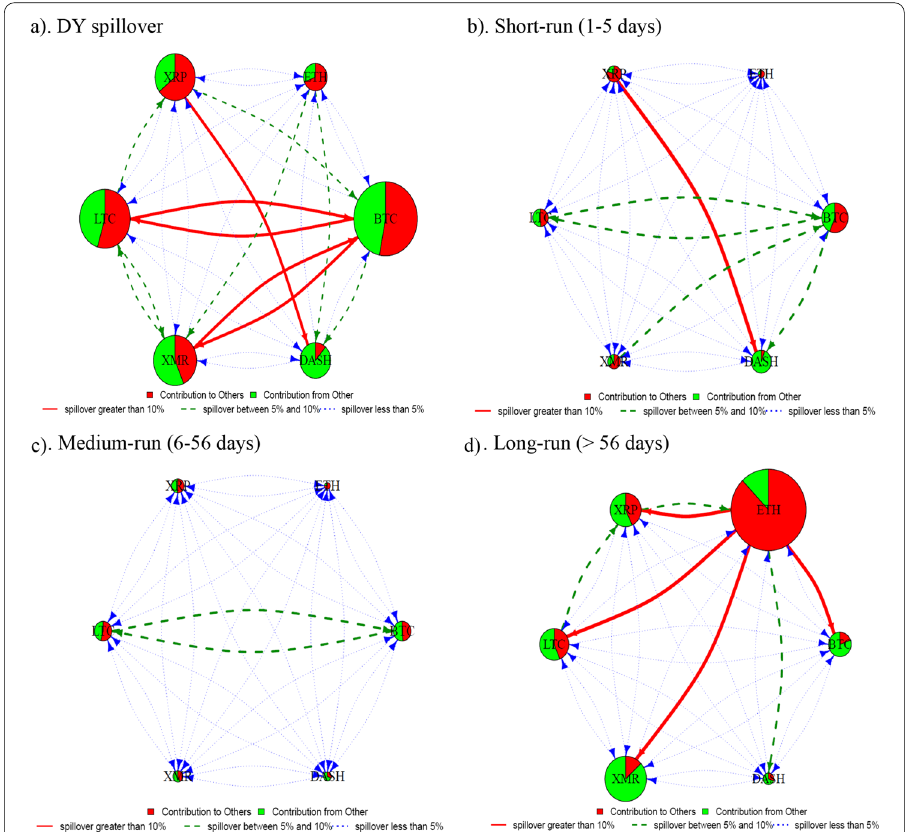
Fig. 7 Robustness check using VoV—spillover